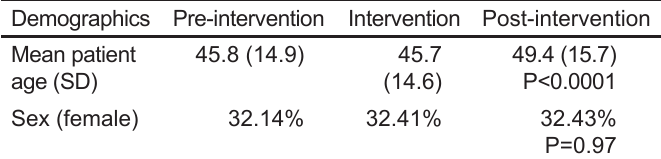
Table 1. Demographics of patients enrolled in study of patients receiving opioid medications for renal colic.